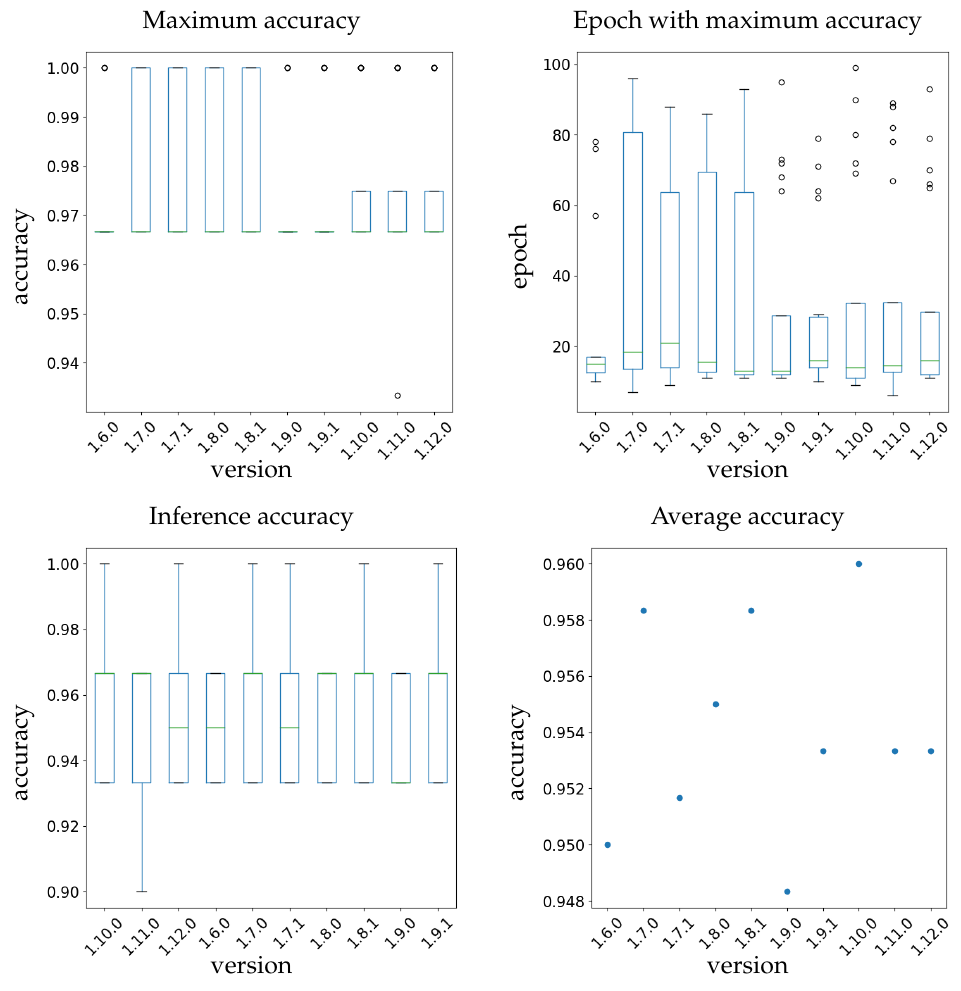
Figure 8. The results for the Iris dataset using